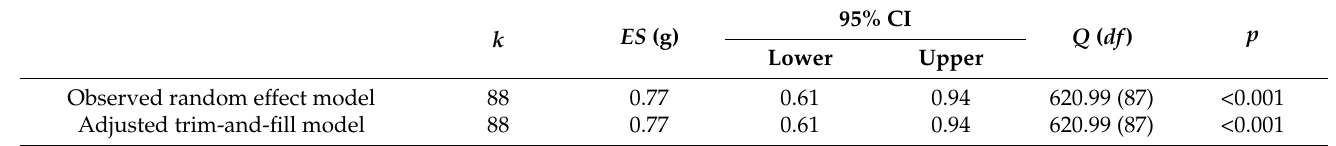
Table 3. Average effect size before and after adjustment for